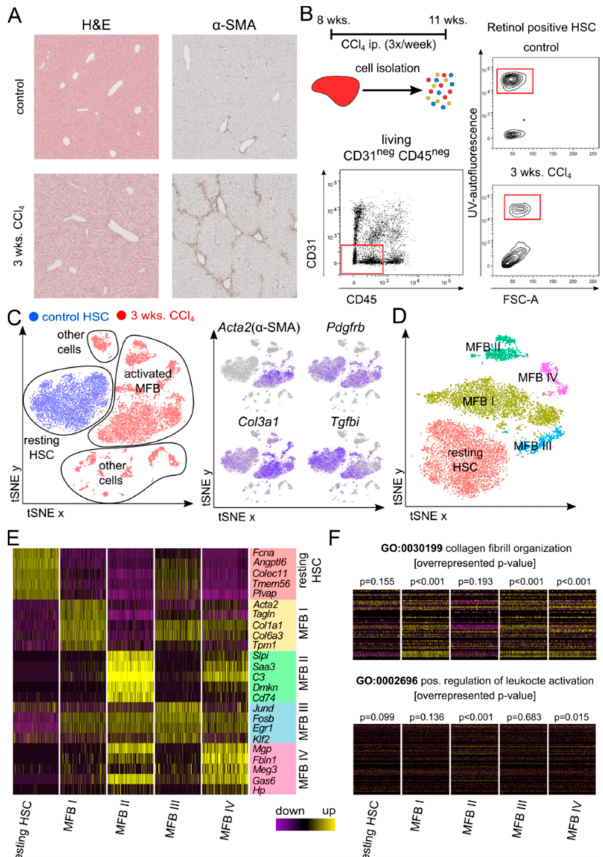
Figure 1. Identification of four sub-populations of activated myofibroblasts (MFB) by single cell RNA sequencing (scRNASeq). ( A ) Representative images of formalin fixed and para ffi n-embedded hematoxylin and eosin (H&E) or anti- α -smooth muscle ( α -SMA) stained liver sections of control mice and mice subjected to repetitive carbon tetrachloride (CCl 4 ) injections for 3 weeks. ( B ) Treatment scheme of mice during CCl 4 treatment. Gating strategy for the isolation of resting hepatic stellate cells (HSCs) from healthy mice and activated MFB from CCl 4 treated mice by FACS. ( C ) t-distributed stochastic neighbor embedding (t-SNE) plots mapping the identity of cells to resting HSCs (blue) and MFB from CCl 4 treated liver (red), and the expression of marker genes used for identifying HSCs and MFB. ( D ) Definitive subset clustering of resting HSCs and activated MFB after exclusion of contaminating cells from scRNASeq data sets. ( E ) Log fold change (avg-logFC) gene expression of the top five marker genes for each cluster. For a better comparability, the number of cells in each cluster is aligned. ( F )